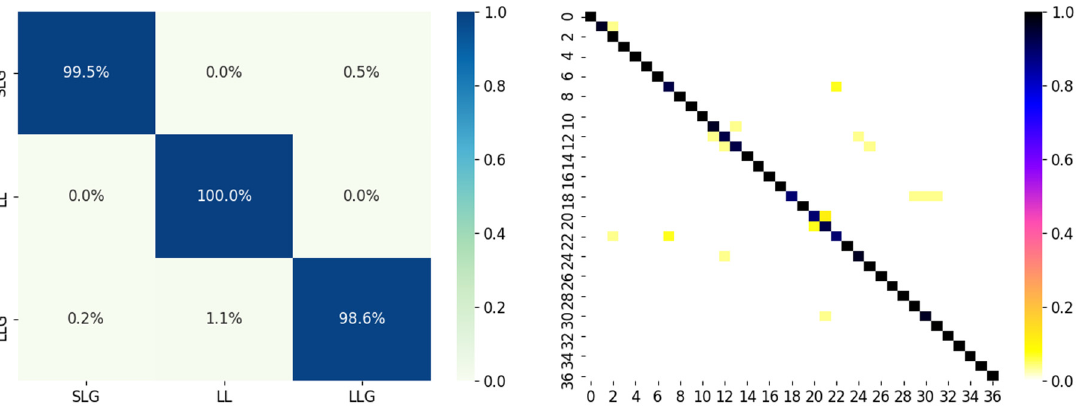
Figure 8. Confusion matrix of performances of fault classification and location in IEEE 37 Bus sys- tem.